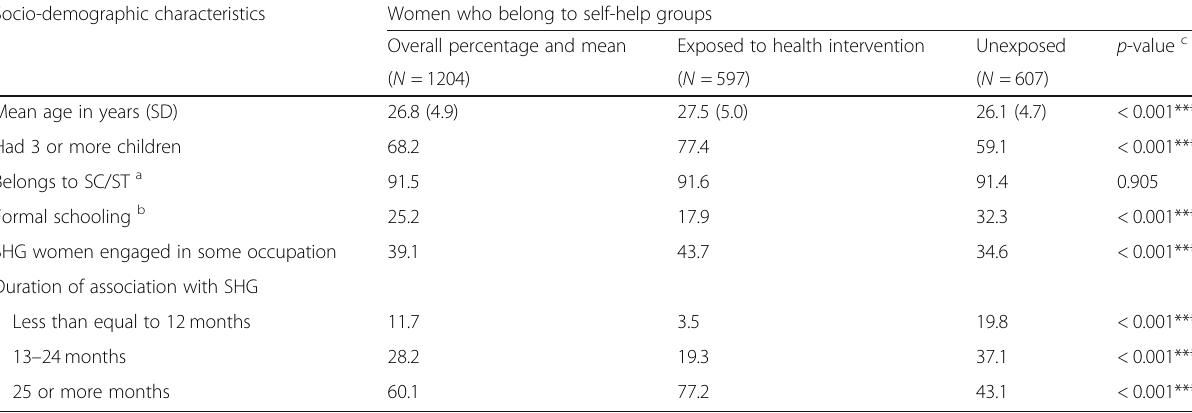
Table 1 Socio-demographic characteristics and exposure to health intervention among women who are part of self-help groups, Bihar, India, 2016 ( N = 1204) Socio-demographic characteristics Women who belong to self-help groups Overall percentage and mean Exposed to health intervention Unexposed p -value c ( N = 1204) ( N = 597)